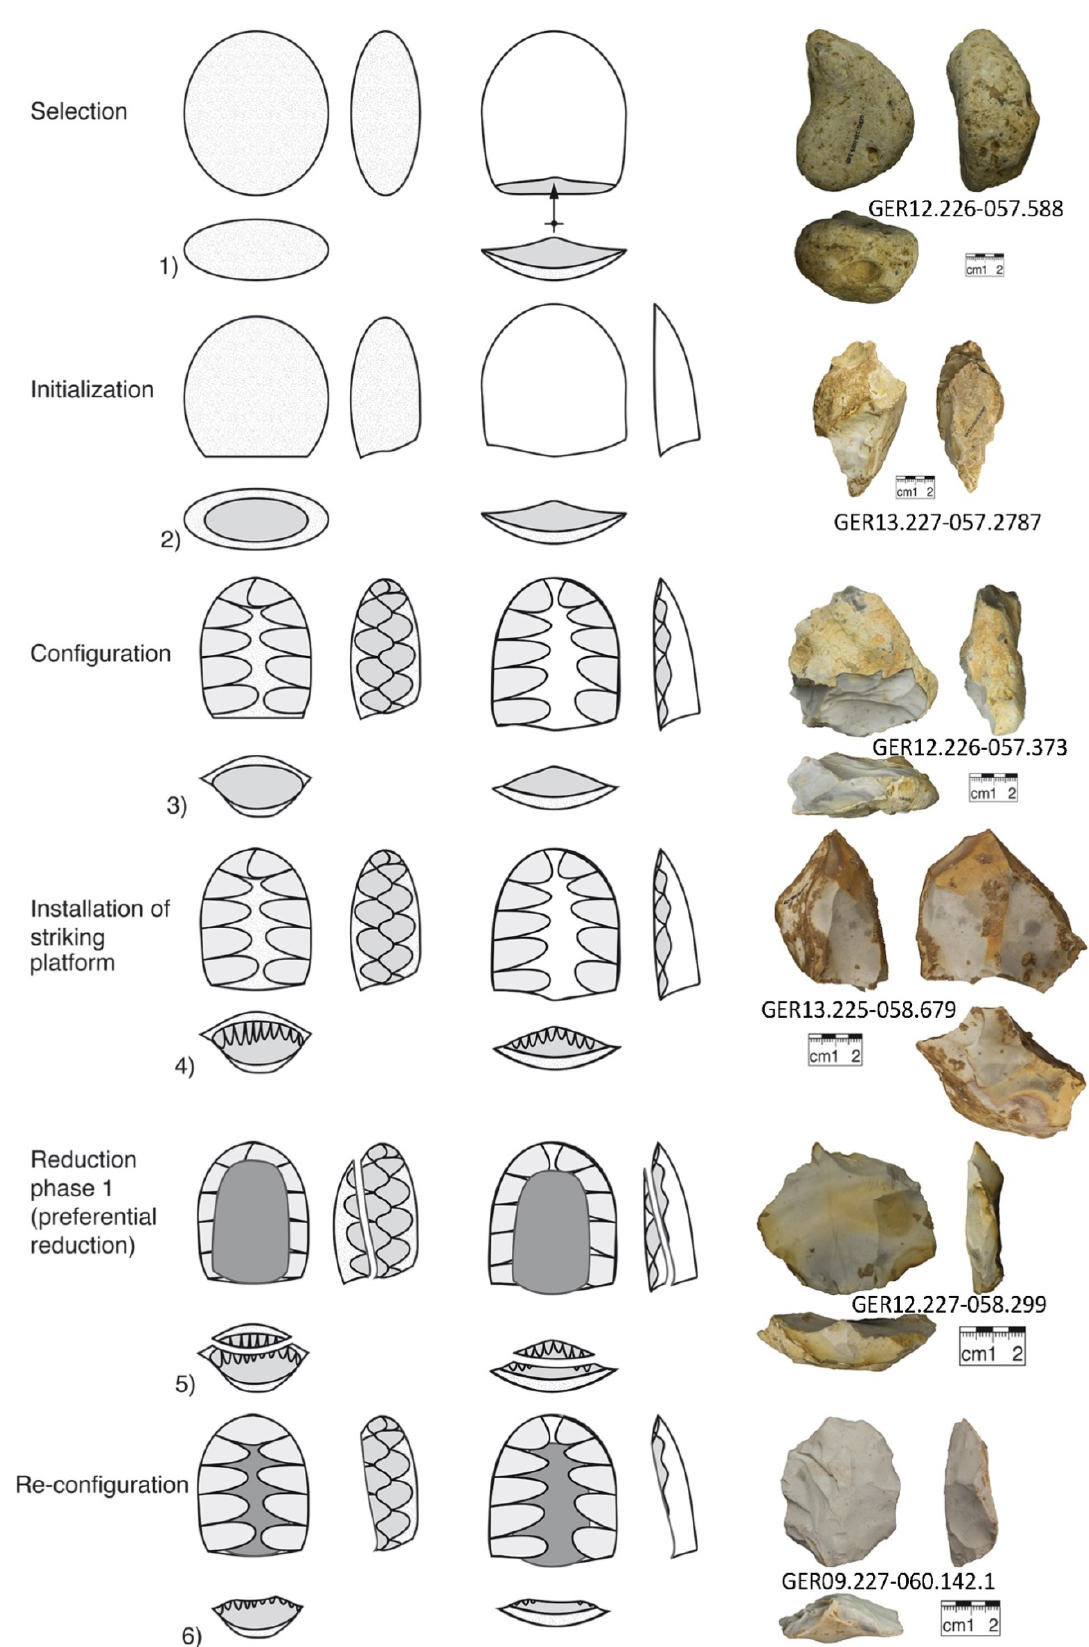
Figure 11. Constructed “standard” procedure for the reduction of Levallois cores from GH 3. Displayed as drawn synopsis (left) and illustrated with the aid of Levallois cores (preforms and exhausted cores) from GH 3 (right). (Scale bars are 2 cm